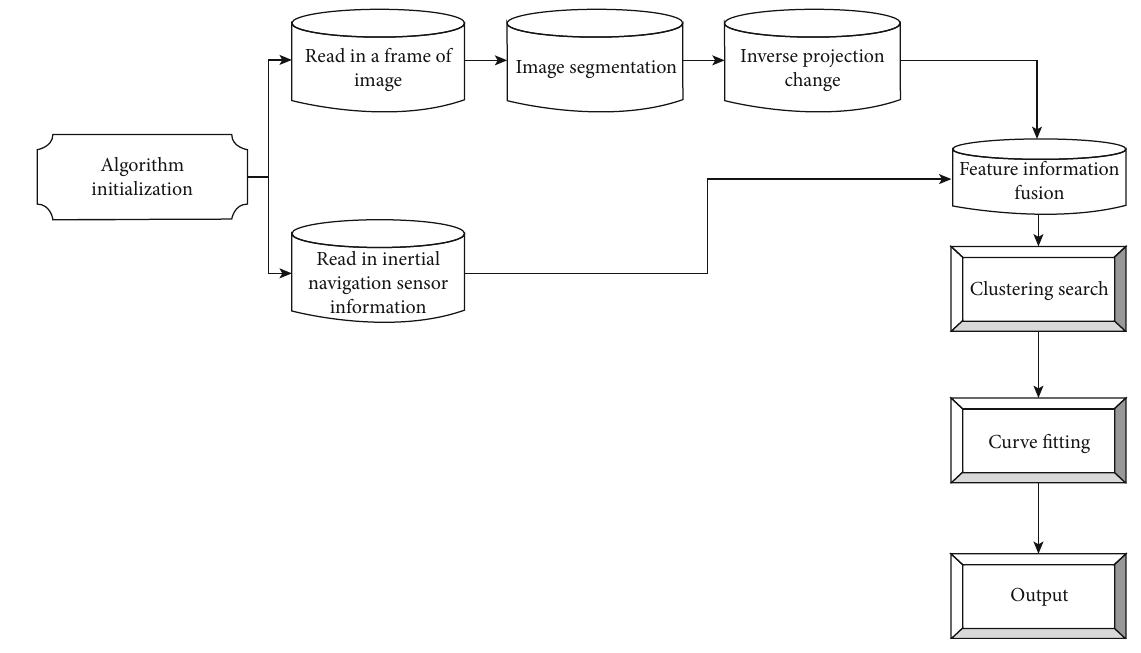
Figure 1: Flow chart of lane detection